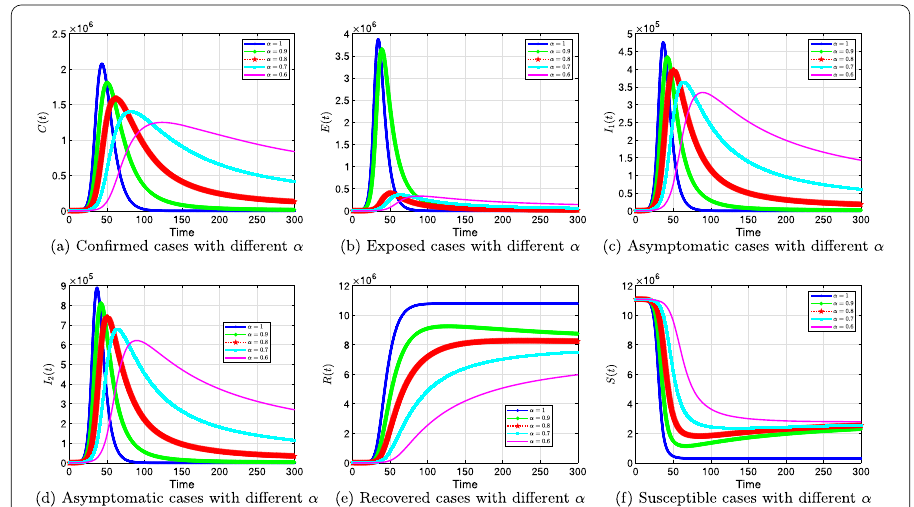
Figure 5 Solution profiles for the COVID-19 model with different